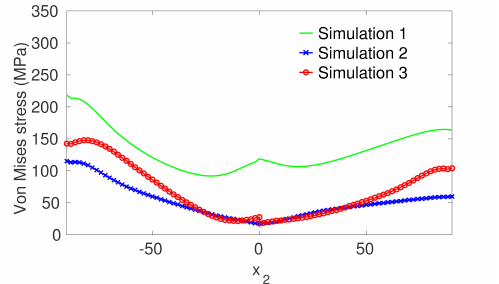
Figure 8. Profiles of Von Mises stress along x 2 through point C (40,0,0) obtained by FE simulations 1, 2 and 3.